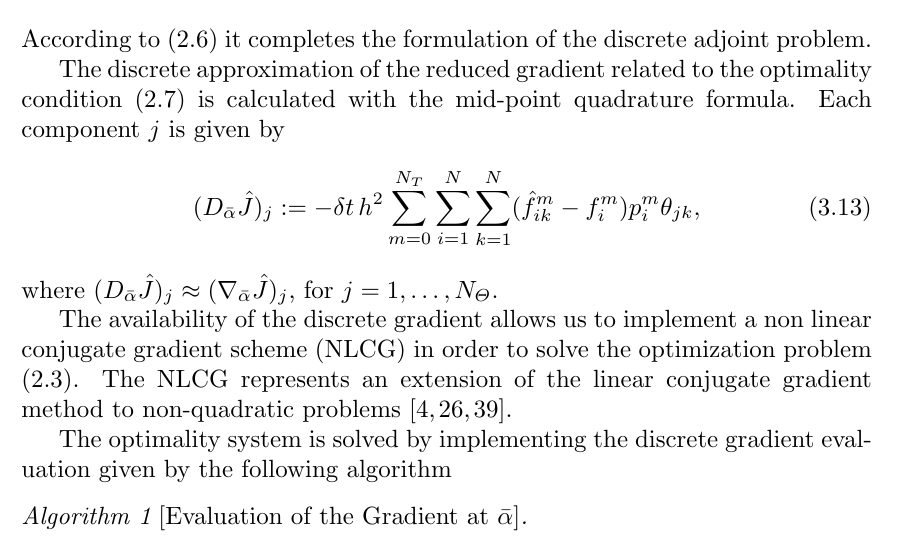
Algorithm 1 [Evaluation of the Gradient at ¯ α ]